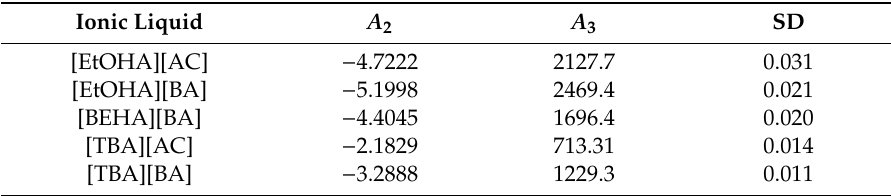
Table 5. Fitting parameters of Equation (4) for dynamic viscosity ( η ) correlation and standard deviation (SD) from Equation